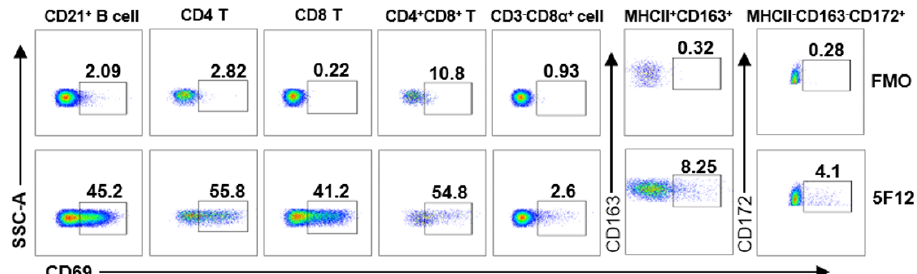
Figure 4. Anti-poCD69 mAb 5F12 is valid for the detection of CD69 expression on different leukocyte subsets of pigs. PBMCs from healthy pigs were stimulated with PMA (50 ng/mL) and ionomycin (500 ng/mL) for 6 h, then stained with a cocktail of antibodies containing Dylight ® 755-CD69, anti- porcine CD3, CD8α, CD4, and CD21 or a cocktail containing Dylight ® 755-CD69, SLA-II DR, CD163, and CD172a. The expression of CD69 on CD21 + B cells (gated on lymphocytes) and T cell subsets (CD4 + , CD8 + , CD4 + CD8 + , gated on CD3 + T lymphocytes), NK cells (gated on CD21 − CD3 − CD8α + cells), monocytes/macrophages (MHCII + CD163 + ), and neutrophils (MHCII − CD163 − CD172 + ) was determined by flow cytometry. Monocytes/macrophages and neutrophils were gated on leukocytes, excluding lymphocytes.